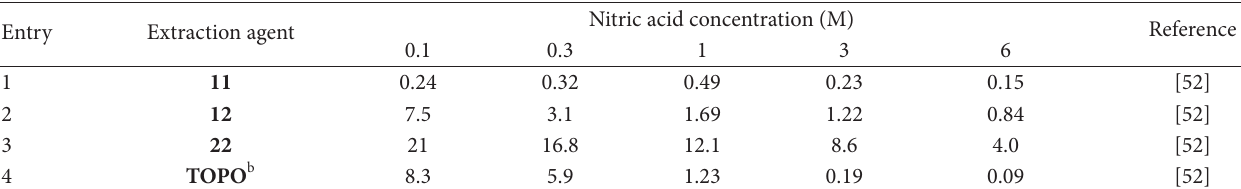
T 7: Extraction of UO 22+ from nitric acid solutions into